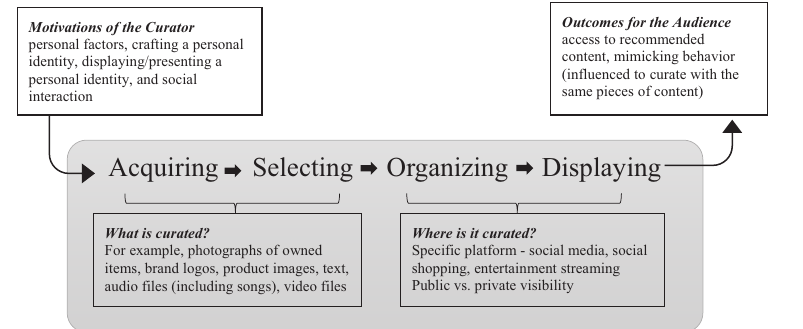
Figure 1. The four steps